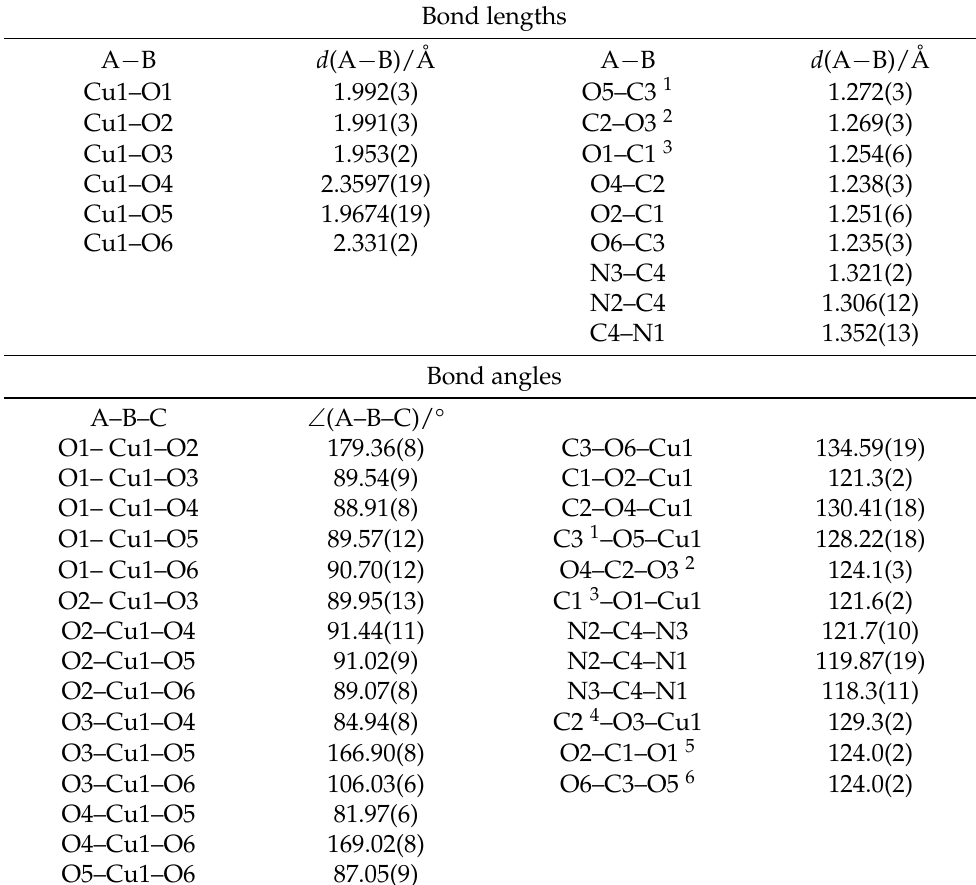
Table A2. Selected bond lengths and angles for [C(NH 2 ) 3 ][Cu(HCOO) 3 ].